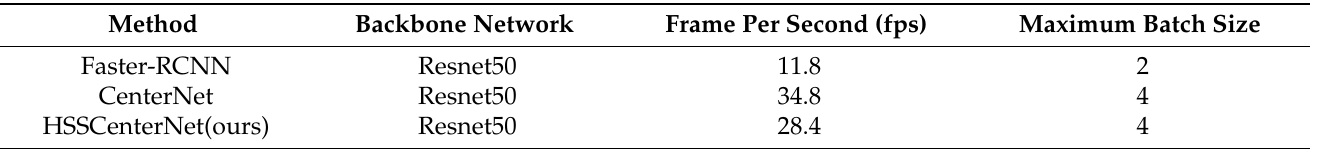
Table 6. Running speed and GPU memory capacity when using a single Nvidia GeForce GTX 1080-Ti GPU to test on the Airbus ship